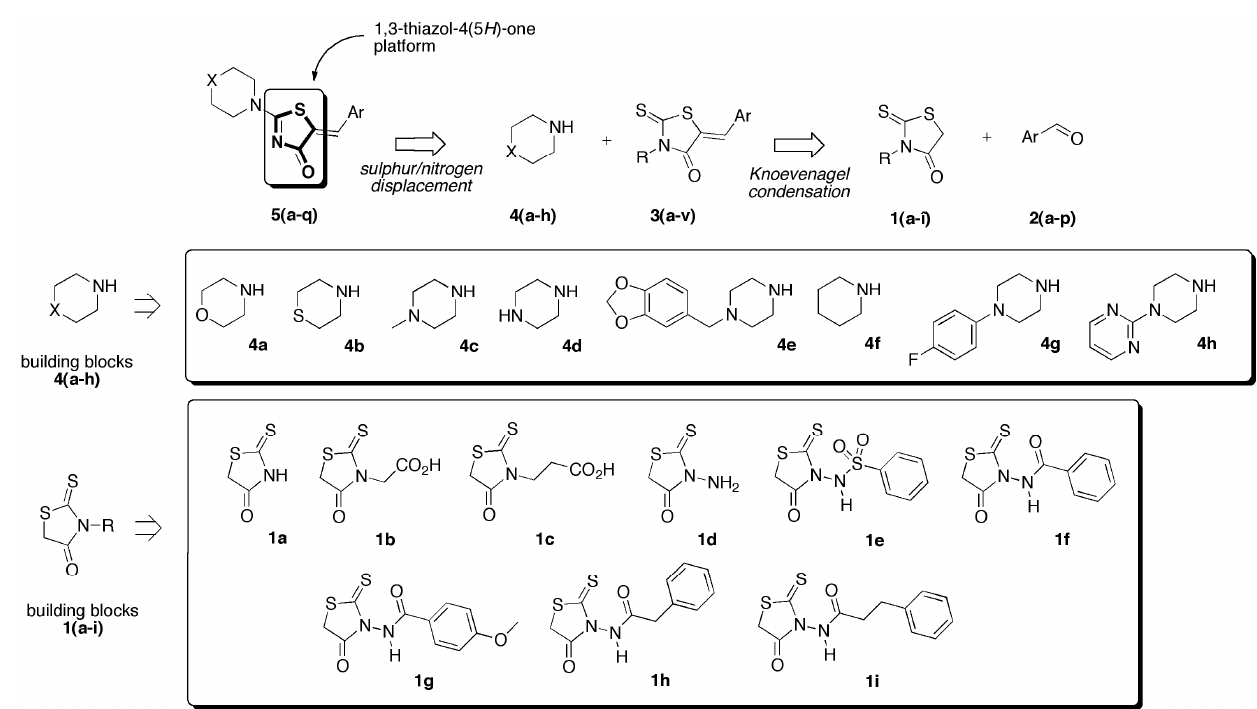
G002 Figure 2. Retrosynthetic strategy toward new (5 Z ) 2-amino-5-arylidene-1,3-thiazol-4(5 H )-ones 5a – q based on the use of